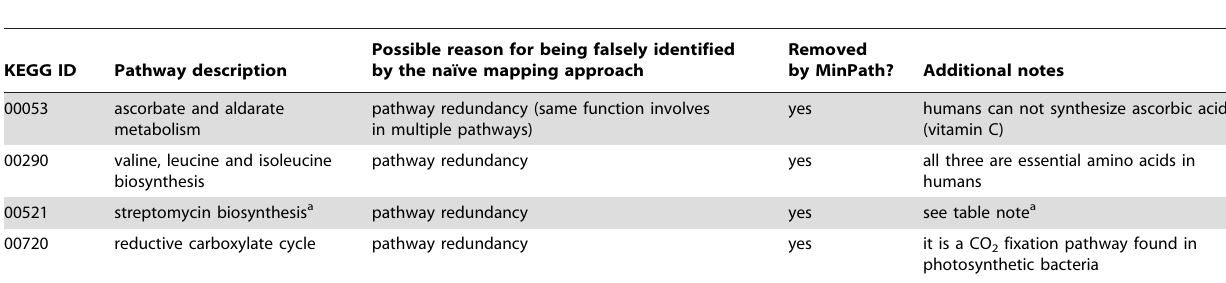
Table 1. Selected spurious pathways of the human genome that are incorrectly identified by the naı¨ve mapping approach.